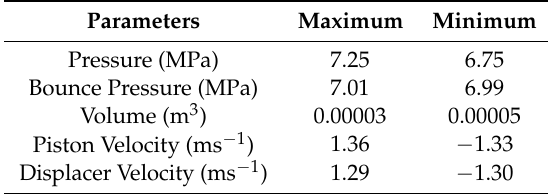
Table 4. Results from the numerical simulation of the FPSE.